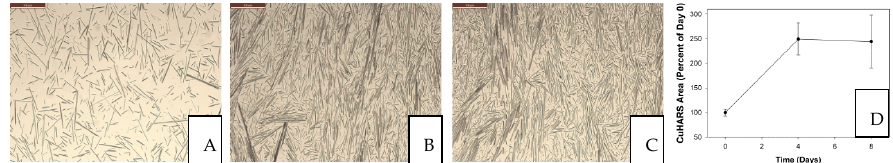
Figure 2. Stability of CuHARS in water. CuHARS at 25 µg/mL in water was added to a 48 well cell culture plate (Greiner) and observed at 0, 4, and 8 days using white light microscopy (panels A , B , and C , respectively). Scale bar in upper left of panels A – C = 100 microns. The area of CuHARS coverage for multiple fields and multiple wells over time was calculated using ImageJ image analysis software (Panel ( D )). Data shown are the averages for 9 analyzed fields for each day with standard error of the mean